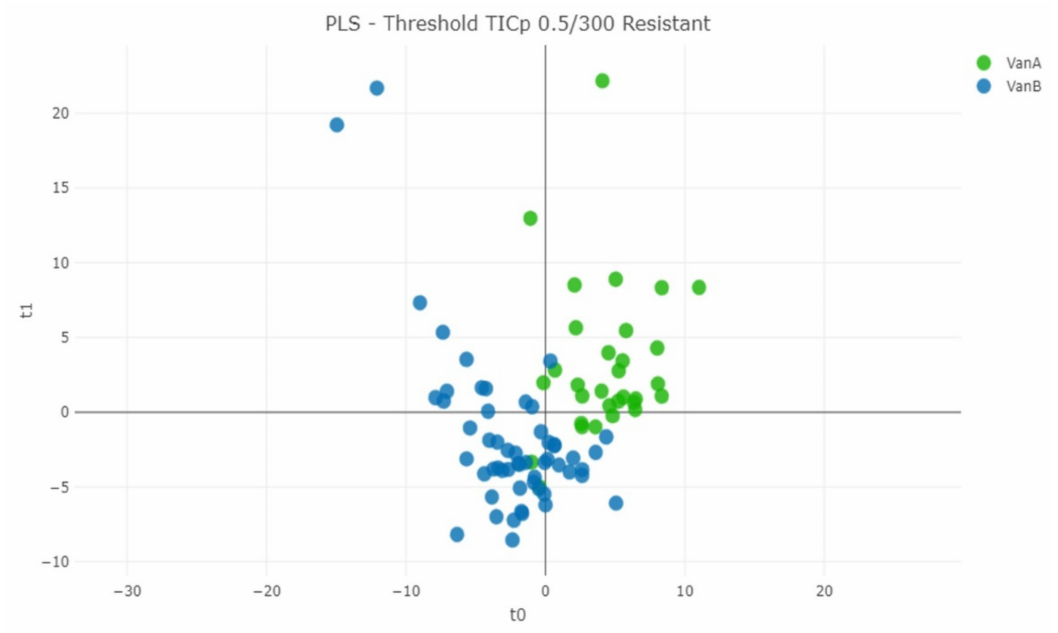
Figure 5. Distance plot of partial least squares–discrimination analysis (PLS-DA) machine learning algorithm for the discrimination of VanA from VanB VRE isolates using the TICp method.